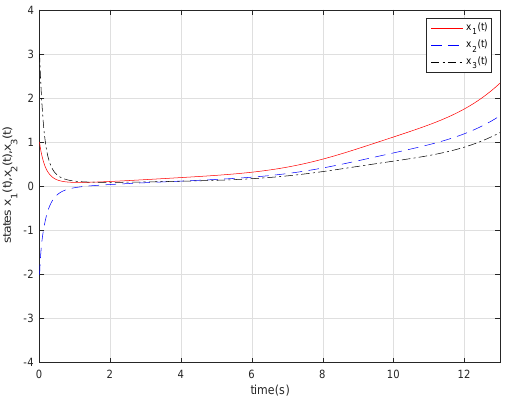
Figure 3. Time response of the selected systems without control input in the Example 2.